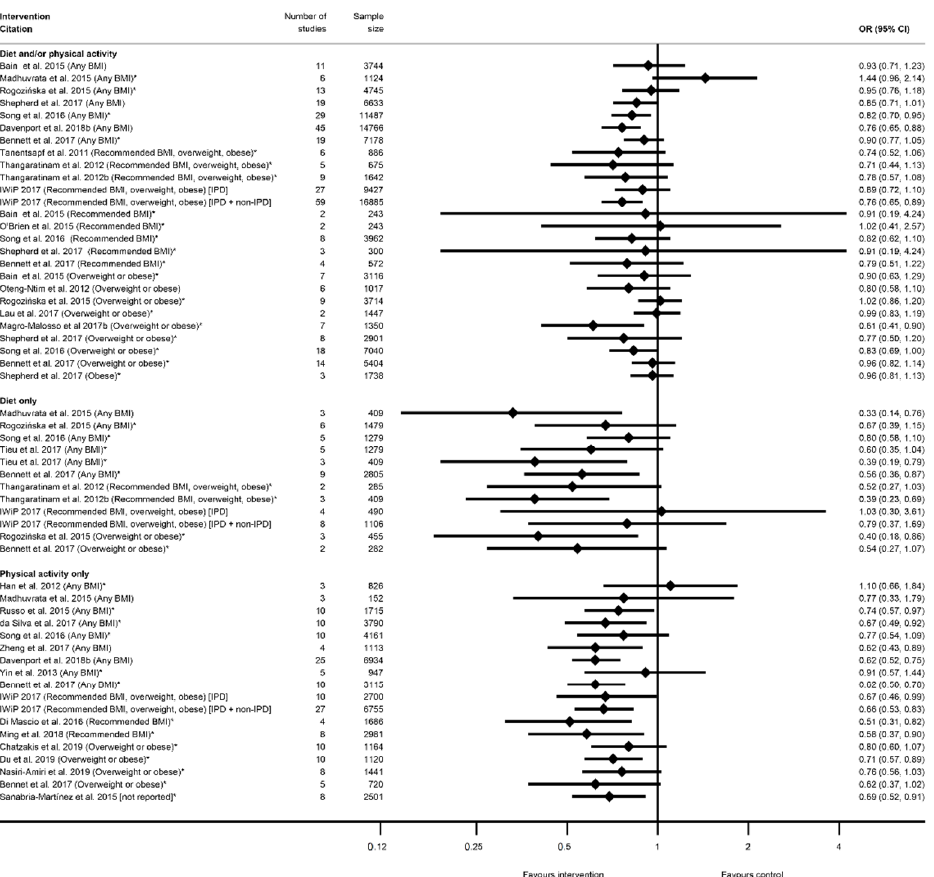
Figure 6. Forest plot of meta-analysis results relating to gestational diabetes (GDM). * indicates the estimate is relative risk.